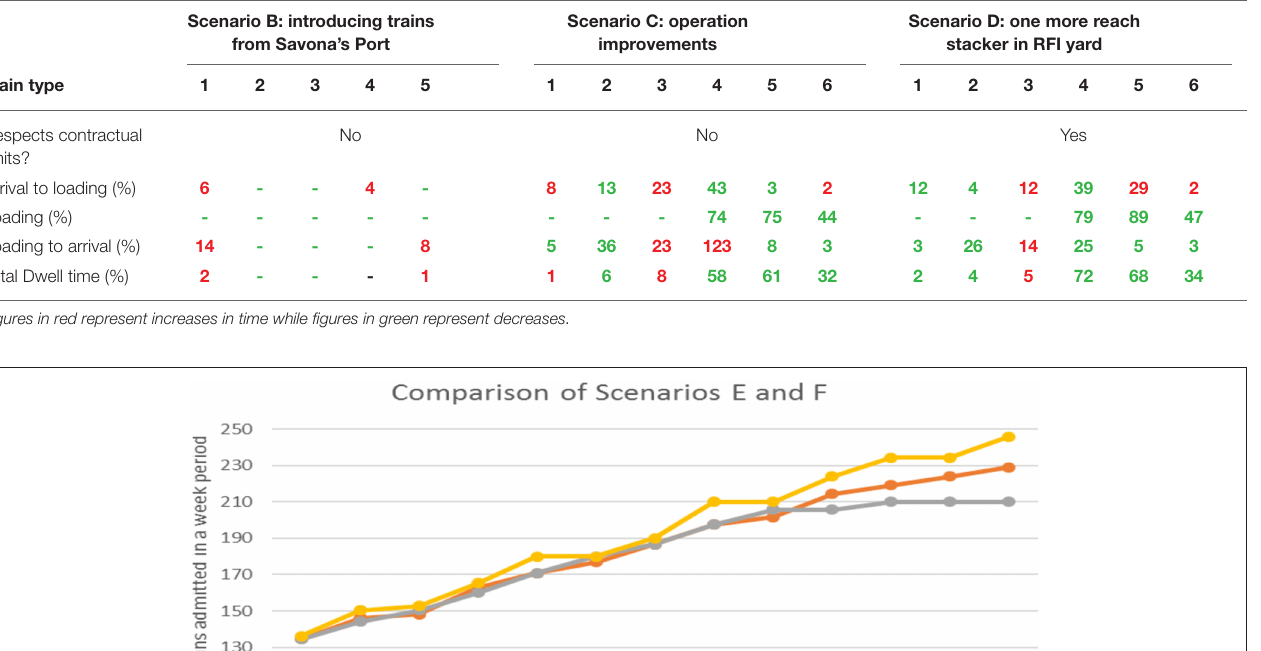
TABLE 3 | Changes in scenario B, C and D regarding scenario A.